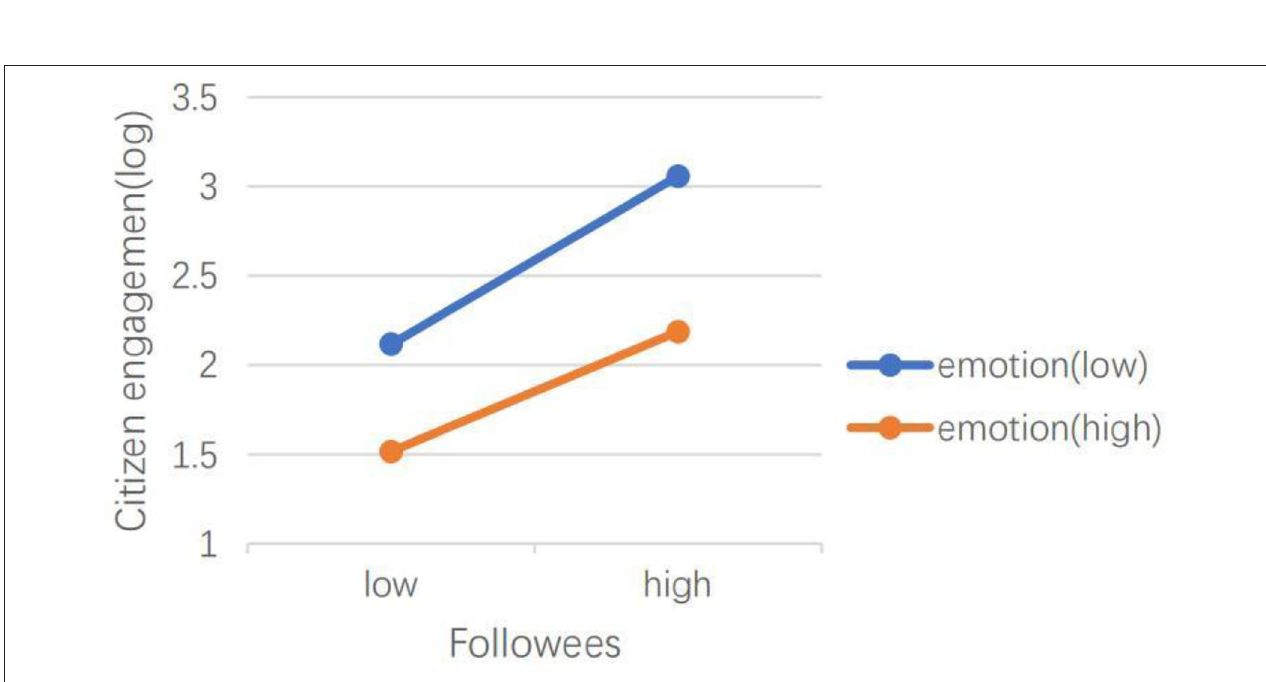
FIGURE 4 | Two-way interaction between the number of followees and emotional valence in predicting CEGSM in the initial containment stage.